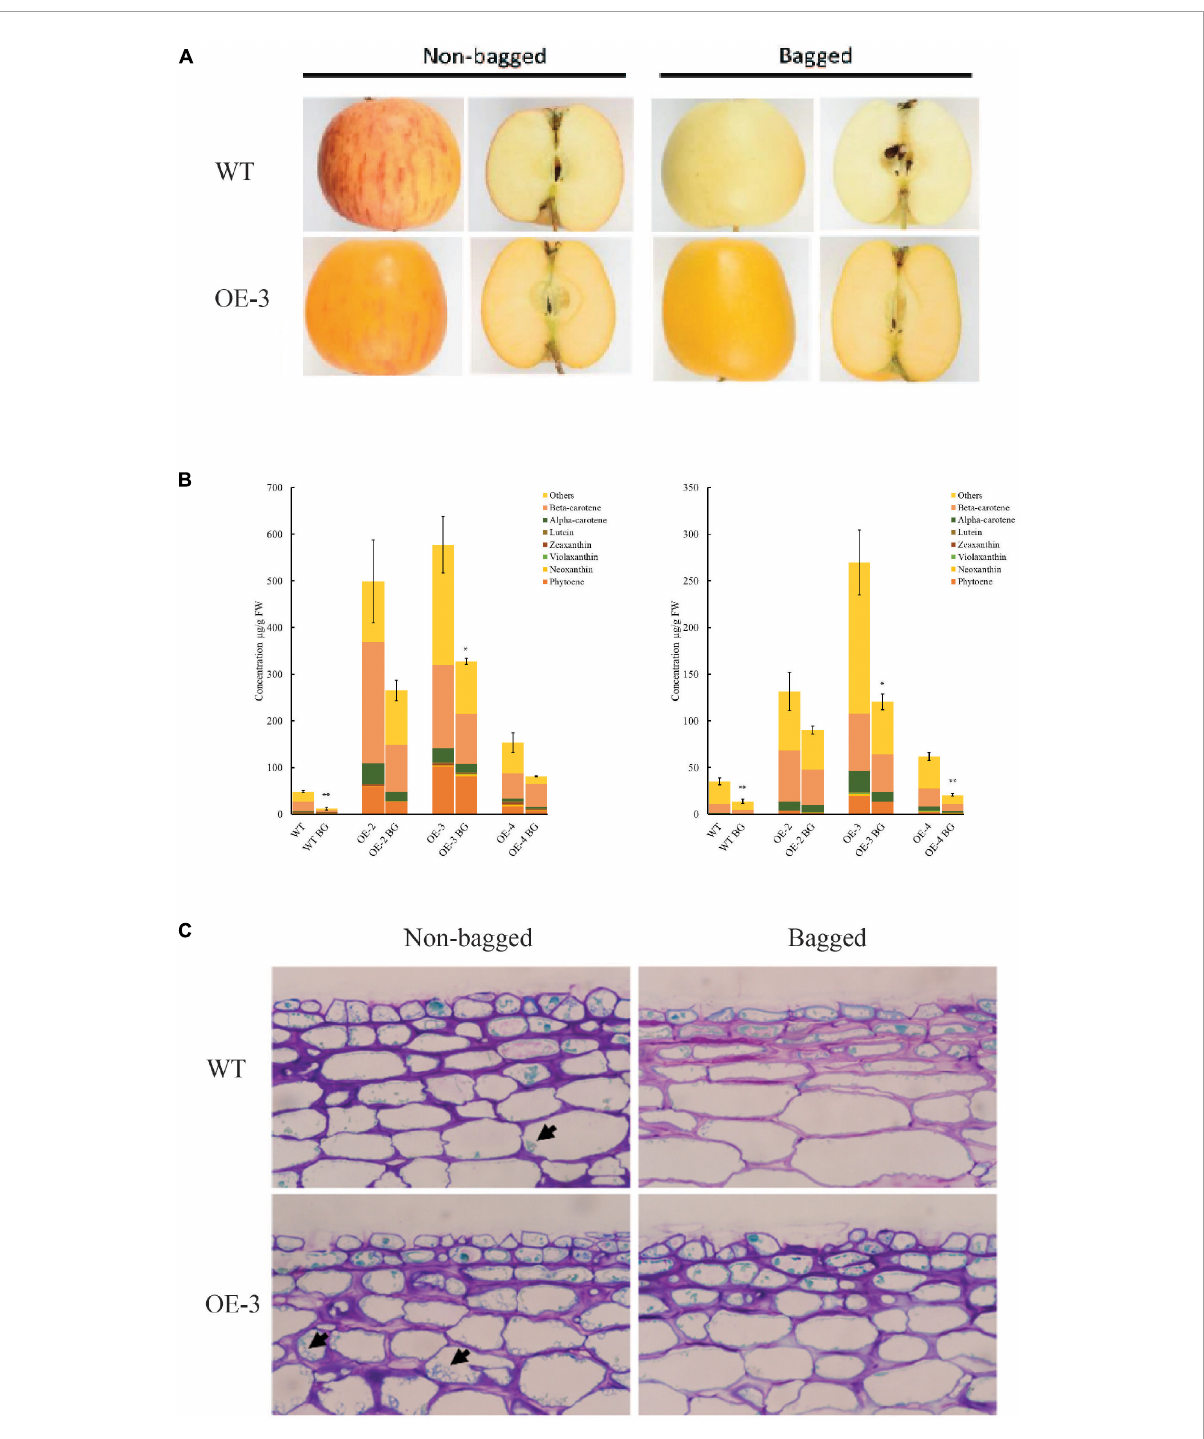
FIGURE6 PSY1 increased fruit carotenoid content in apple in the absence of light. (A) Representative bagged and non-bagged fruit of WT and PSY line OE-3 at 150 D. (B) Graphs showing carotenoid content in fruit skin (left) and flesh (right) of different PSY lines (OE-2, OE-3, OE-4) and WT. Error bars represent standard error of total carotenoid contents of three biological replicates. Bar graph with asterisk show significant difference from the non-bagged fruit of the same line using Dunnett’s test (* P < 0.05; ** P < 0.01). (C) Stained fruit sections of WT and OE-3 displaying plastids (arrowed) in the